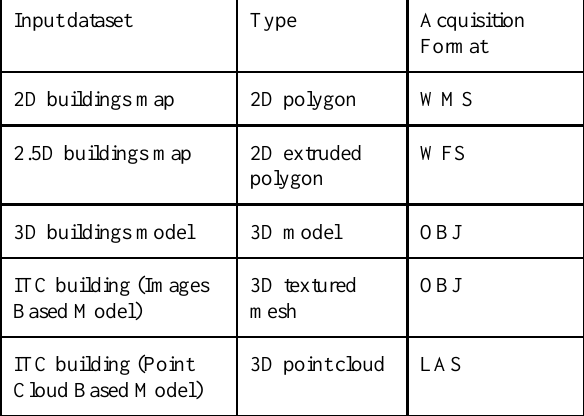
Table 1 . Input dataset integrated into the platform